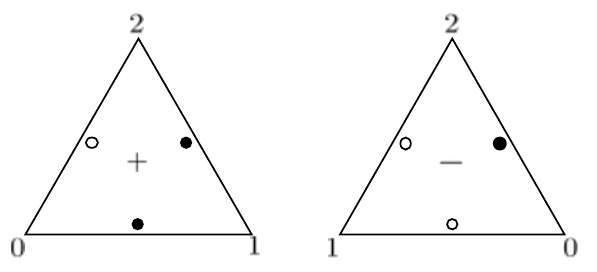
Figure 3 . Assignment of Grassmann variables on 1-simplices in the case of d = 2. (cid:18) (resp. (cid:18) ) is represented as a black (resp. white)